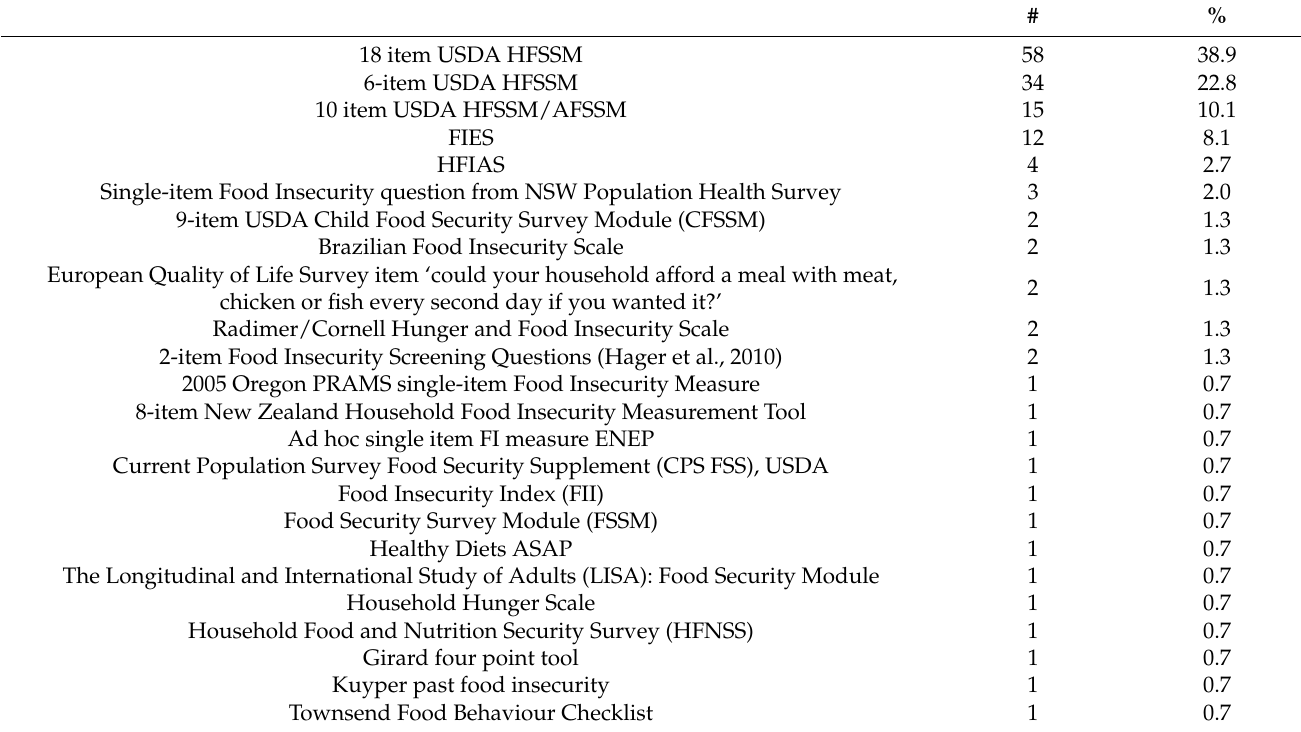
Table 3. Measures of food insecurity identified in this review, and frequency of use in the different